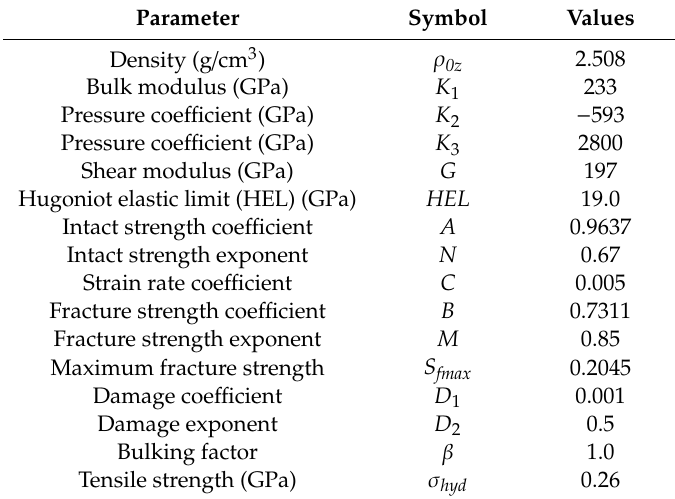
Table 3. The parameters for boron carbide used in Johnson–Holmquist’s model [19]. Parameter